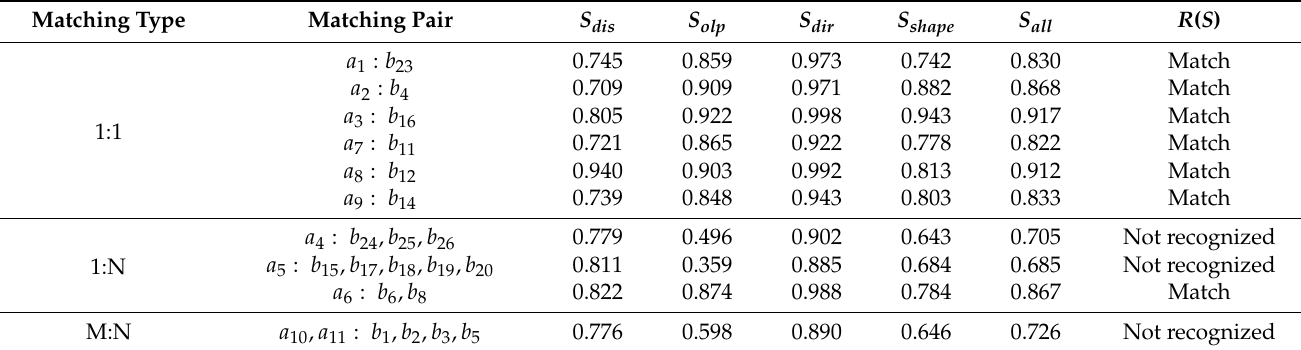
Table 1. Experimental results of the four similarity evaluation indices (Section 2.1).